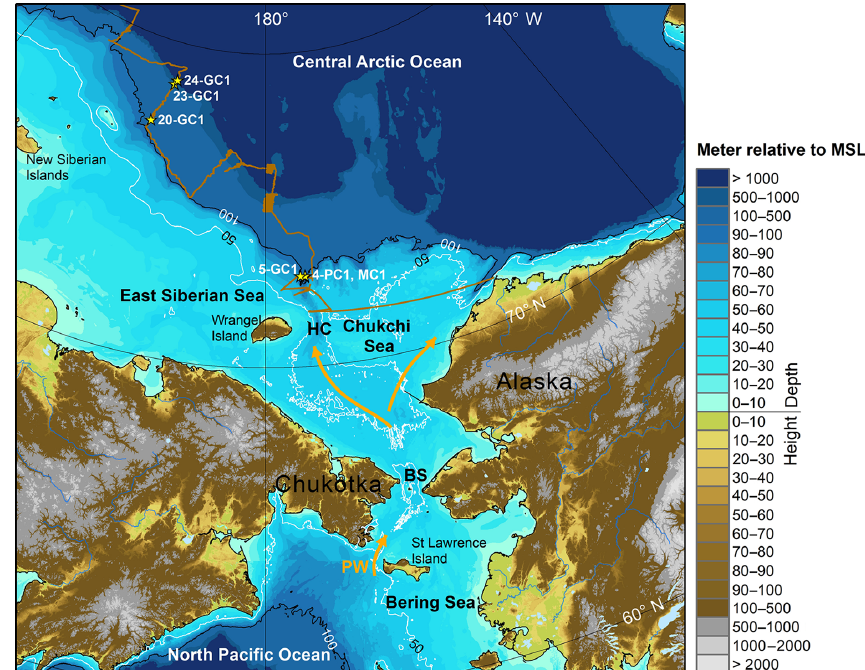
Figure 1. Map showing the approximate cruise tract of the SWERUS Leg 2 2014 expedition and the locations of cores SWERUS-L2-4-PC1 and SWERUS-L2-20-GC1 used in this study. Details on the cores can be found in Table